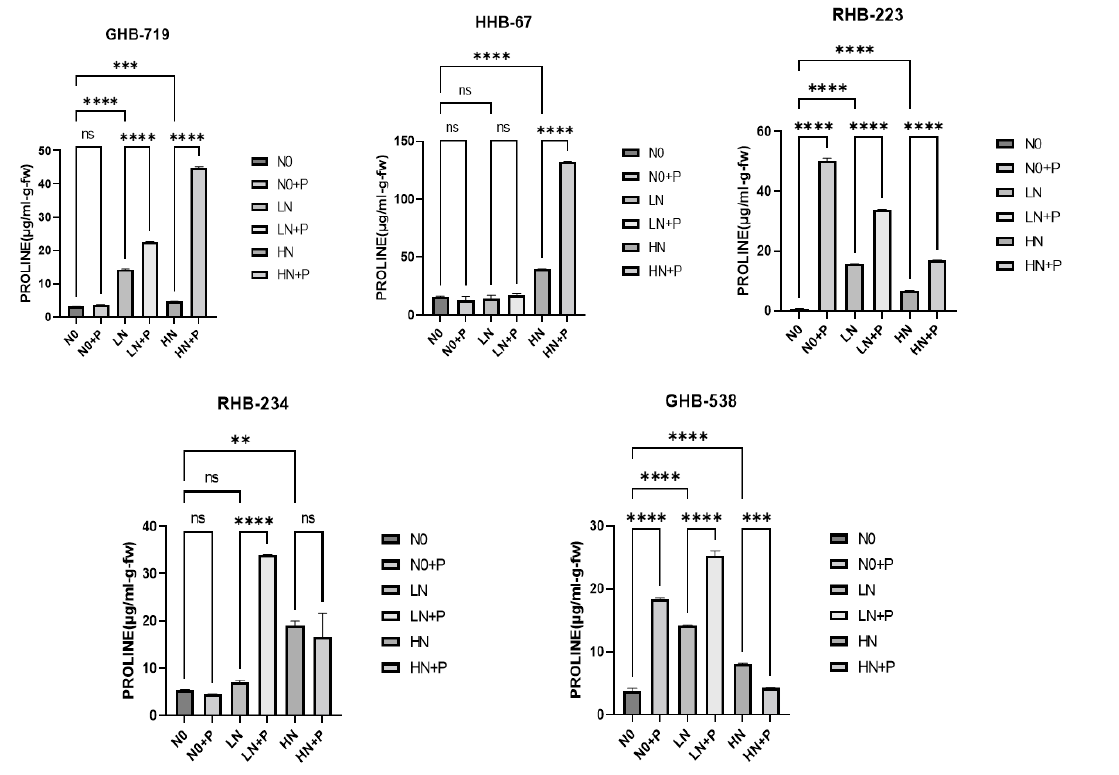
Figure 3. Proline content in the leaf of pearl millet treated with different N and drought stress (PEG-6000-10%). Bars are means ± standard error (n = 3). In the above bar (****,***,**,*) represents differences among treatments (Tukey’s test, p ≤ 0.0001), while ns represents no significant difference.